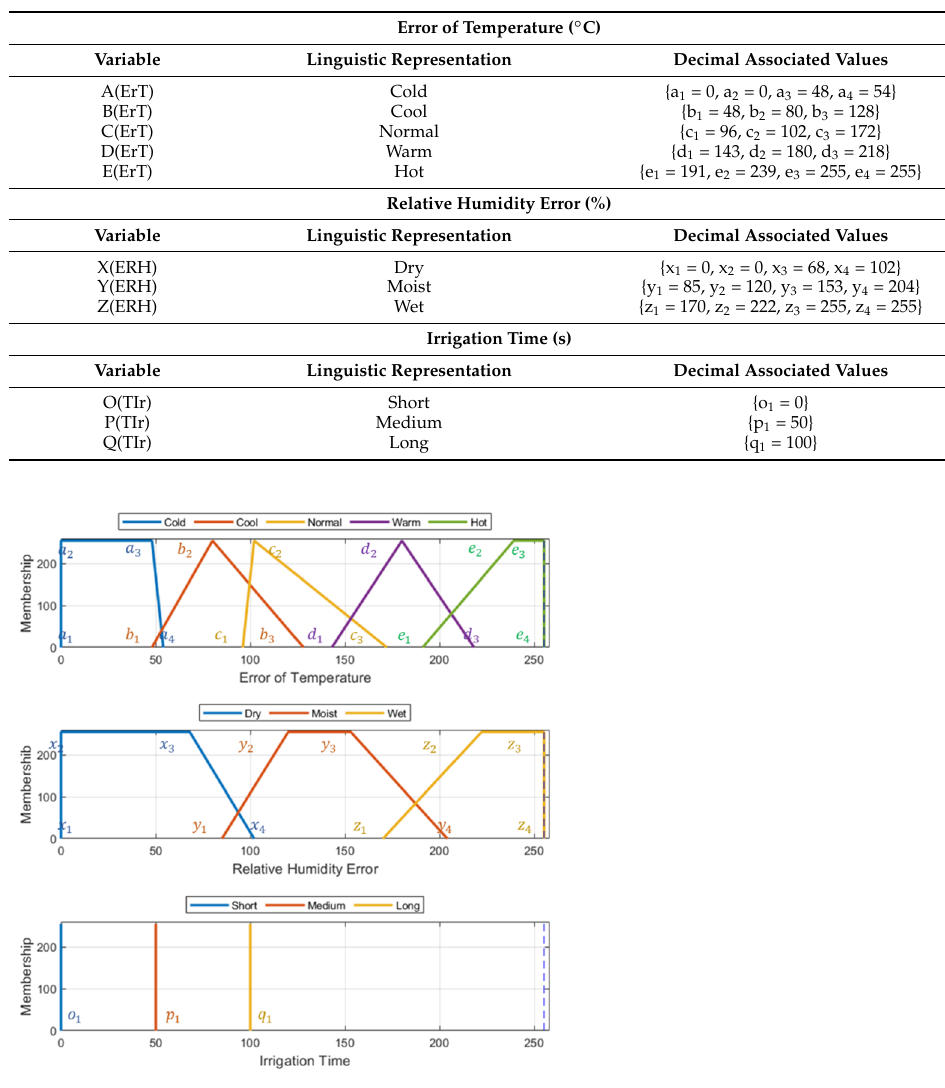
Figure 2. Membership functions representing environmental temperature, relative humidity, and irrigation time, with values between 0 and 255 bits and with membership levels from 0 to 1.